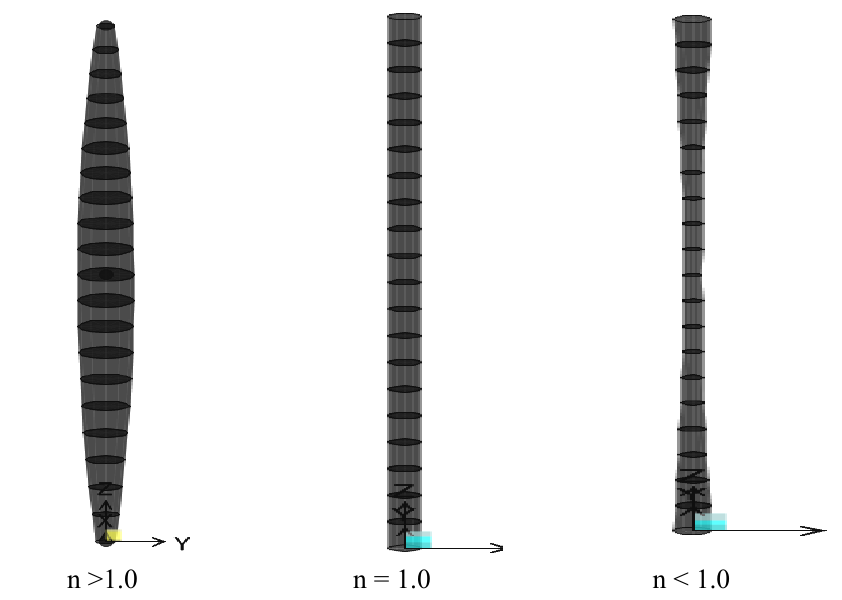
Fig. 2. Finite element model of the Column under